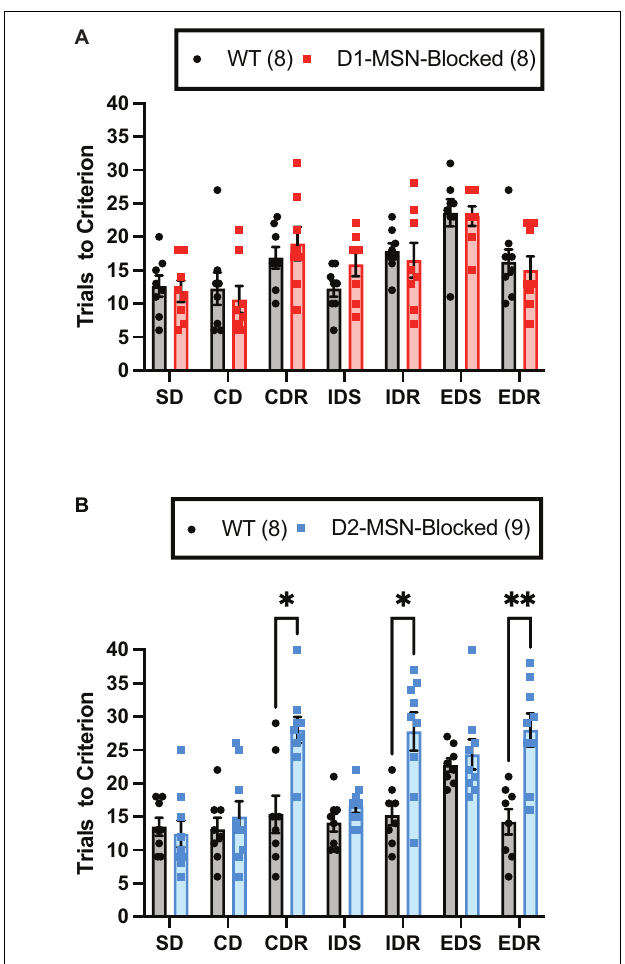
FIGURE 2 | Reversal learning, but not set-shift or discrimination learning, requires neurotransmission in NAc Core D2-MSNs. NAc Core D1-MSN-Blocked ( n = 8) (A) and D2-MSN-Blocked ( n = 9) (B) mice did not differ from wildtype (WT) mice ( n = 8, respectively) in their ability to perform discrimination (SD and CD) and set-shifting (IDS and EDS) stages of the attentional set-shifting task (ASST). However, D2-MSN-Blocked, but not D1-MSN-Blocked, mice were impaired in their ability for reversal learning during all three reversal stages (CDR, IDR, and EDR). Bars represent mean ± SEM; Bonferroni post-hoc tests ( ∗ p < 0.05, ∗∗ p <